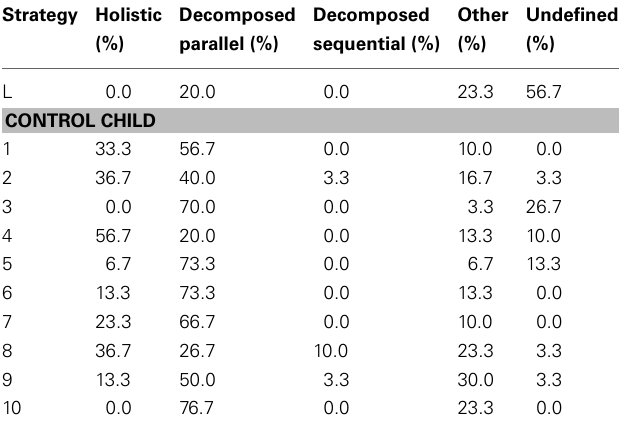
Table A5 | Overview of the individual percentages of the processing strategies in the symbolic 0–1000 number line task of the child with dyscalculia and the control children.